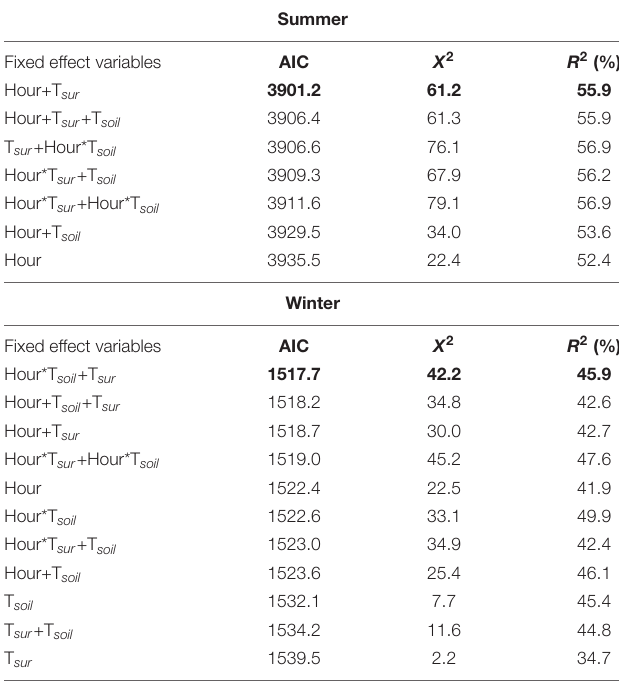
TABLE 1 | Comparison between generalized linear models built to explain the counts of surface episodes every 3 h in summer and winter, using different combinations of the environmental